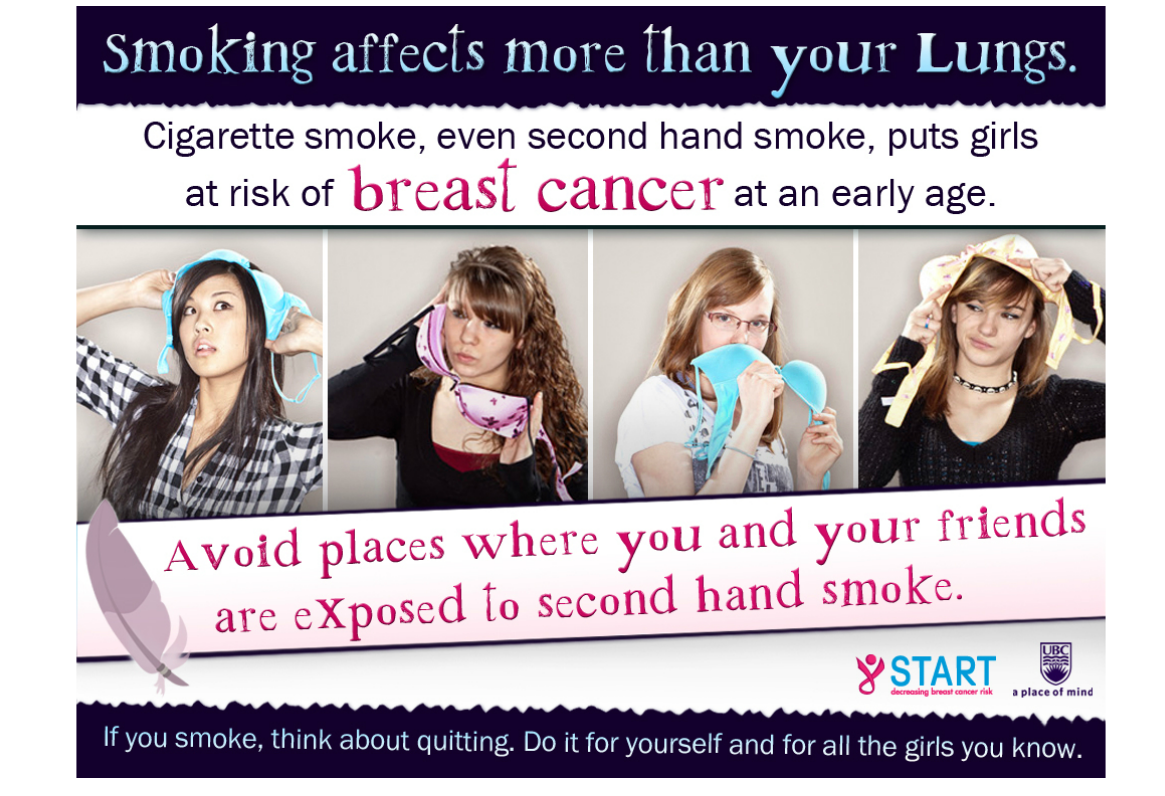
Figure 2. Gender- and Aboriginal status-sensitive, targeted intervention message for girls. Source: Created by START study authors, who hold copyright to the